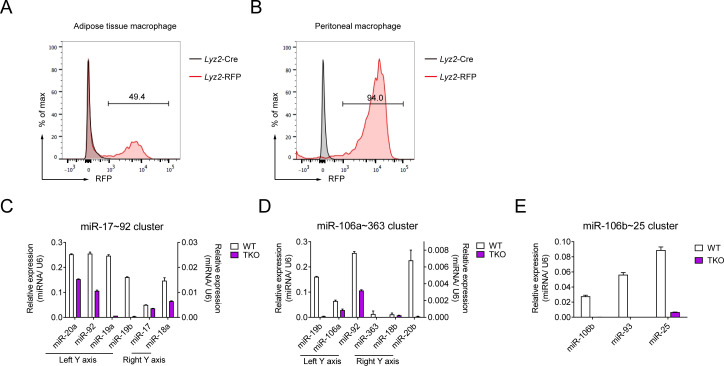
The miR-17~92 family miRNAs are efficiently deleted in TKO adipose tissue macrophages (ATMs).(A and B) Flow cytometry analysis of RFP expression in ATMs (A) and peritoneal macrophages (B, positive control) from Lyz2-Cre and Lyz2-RFP mice. (C–E) qPCR analysis of various mature miRNAs (horizontal axes) in the miR-17~92 cluster (C), miR-106a~363 cluster (D), and miR-106b~25 cluster (E) in Lyz2-Cre (WT) andTKO ATMs; results are presented as relative expression normalized to the control small RNA U6. Data are representative of two independent experiments (mean + s.d.).